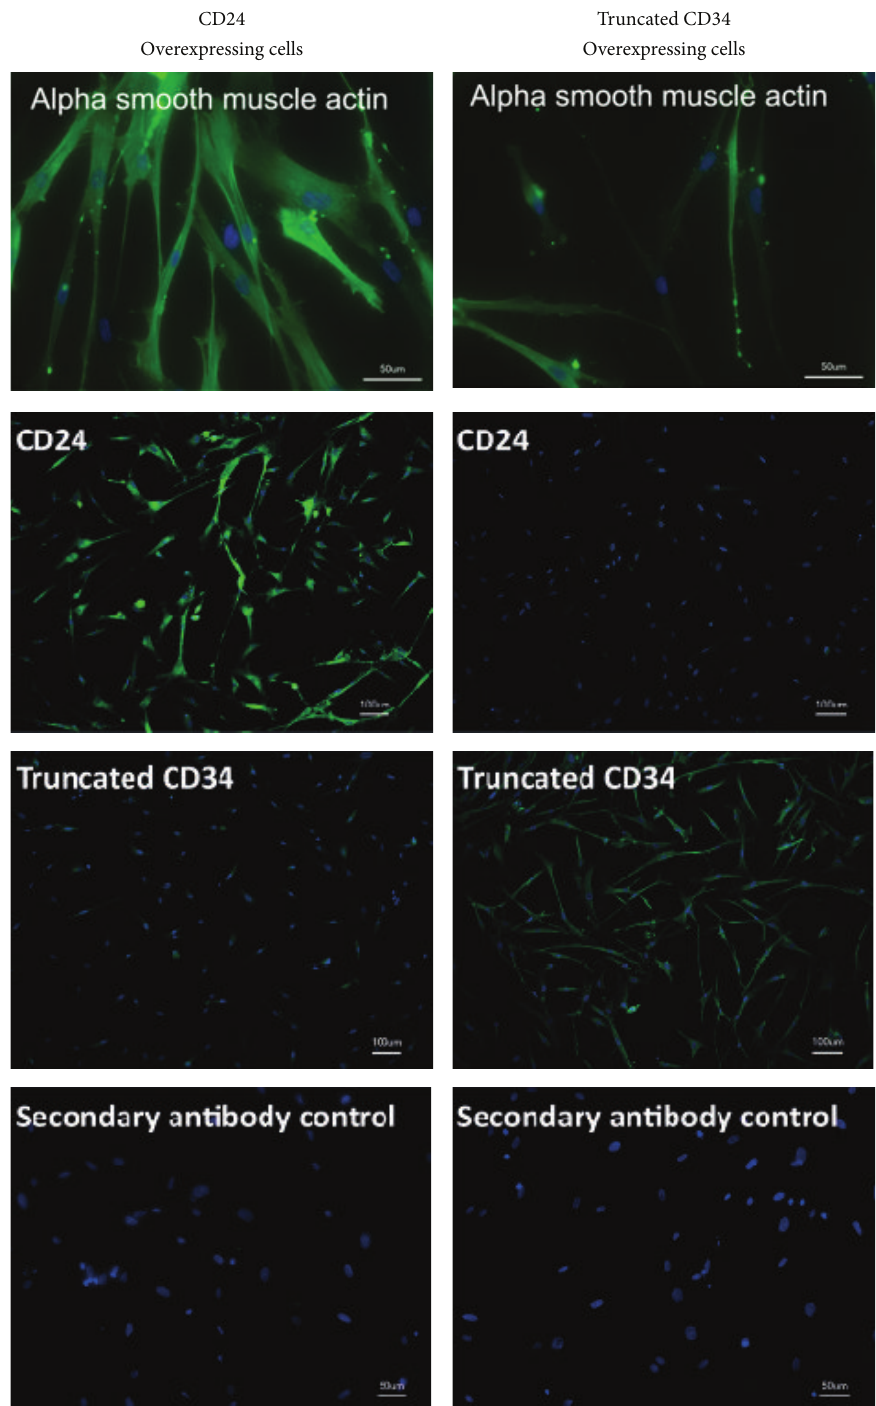
Figure 5: Expression of alpha smooth muscle actin. Intracellular immunocytochemical staining of alpha smooth muscle actin after overexpression of CD24 (CD24, left column) or truncated CD34 as control (CD34, right column). Alpha smooth muscle actin: staining of alpha smooth muscle actin (green), and nuclear staining (blue) show that in hBMSCs overexpressing CD24 reactivity for alpha smooth muscle actin increases relative to control cells (Scale 50 𝜇 m). CD24: staining of CD24 (green), and nuclear staining (blue) verify that transduction rate of CD24 is nearly complete (Scale 100 𝜇 m). CD34: staining of CD34 (green), and nuclear staining (blue) verify that control cells were transduced efficiently with truncated CD34 (Scale 100 𝜇 m). Secondary antibody control: staining control with secondary antibody only (green) and nuclear staining (blue) (Scale 50 𝜇